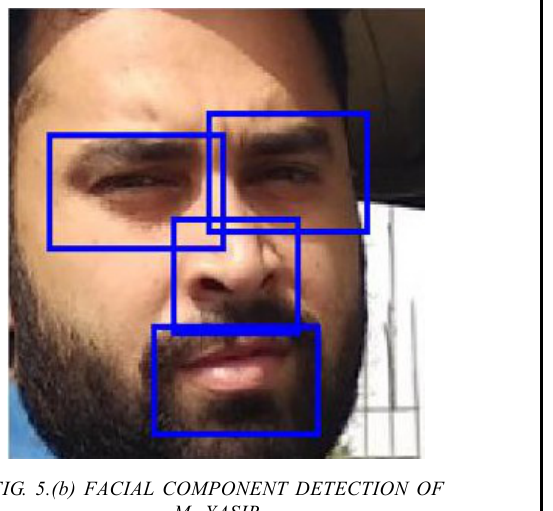
FIG.7. (b) NUMBER PLATE IDENTIFIED USING